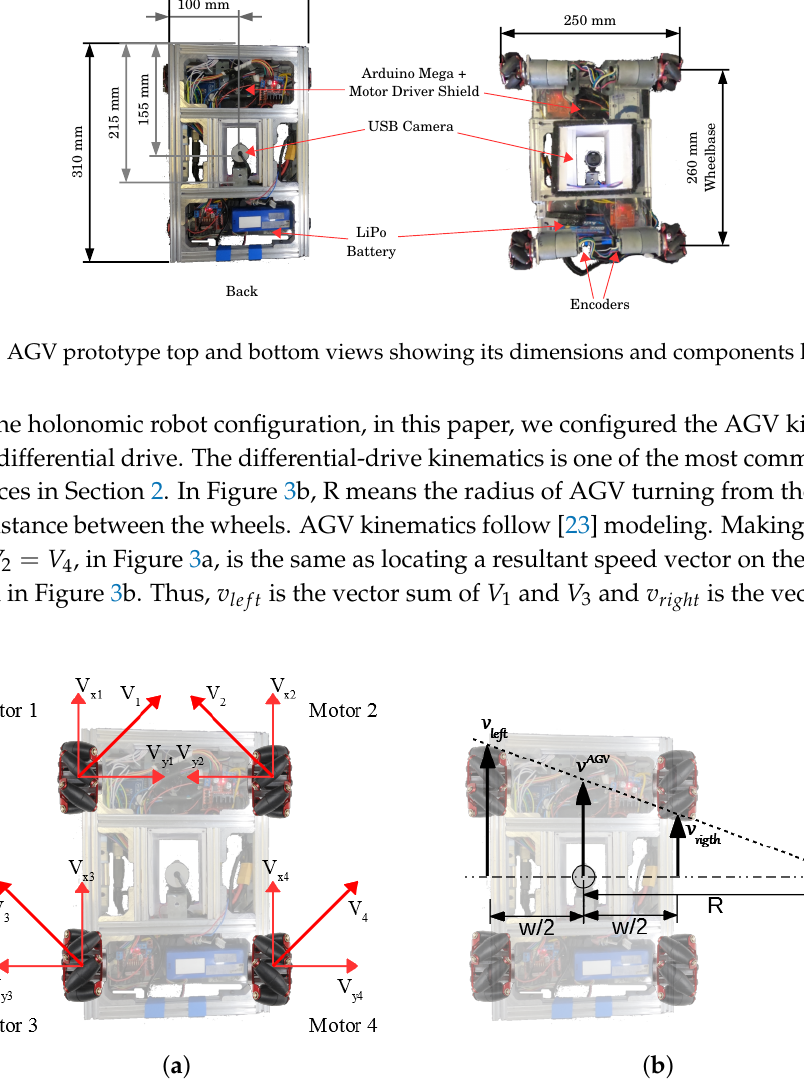
Figure 3. AGV kinematics. ( a ) example of wheels resultant forces applied to the AGV. ( b ) Wheels speed intensity